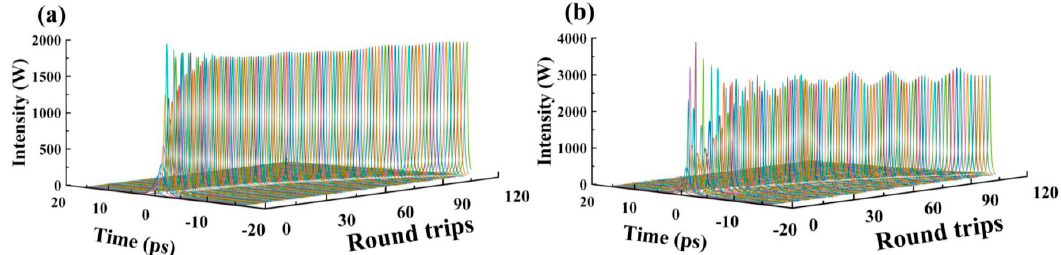
Figure 6. Pulse evolution for g 0 = 1.15 m − 1 ( a ) and 1.5 m − 1 ( b ) with round trips.